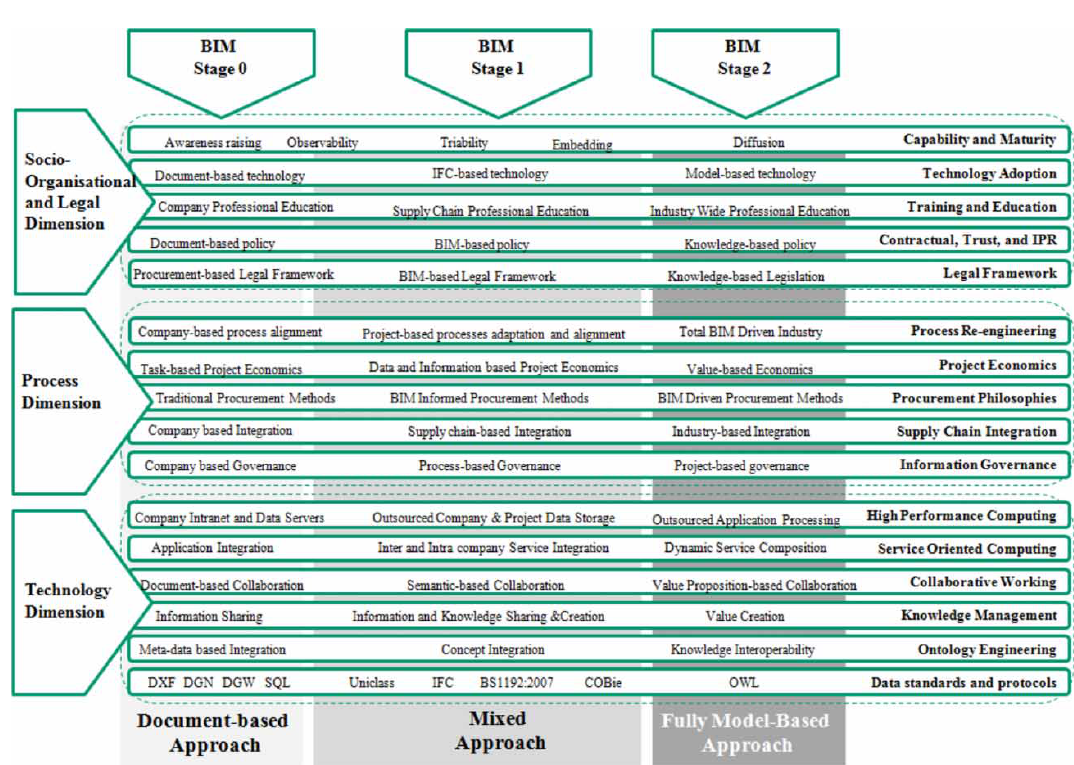
Fig. 15. BIM research and development roadmap